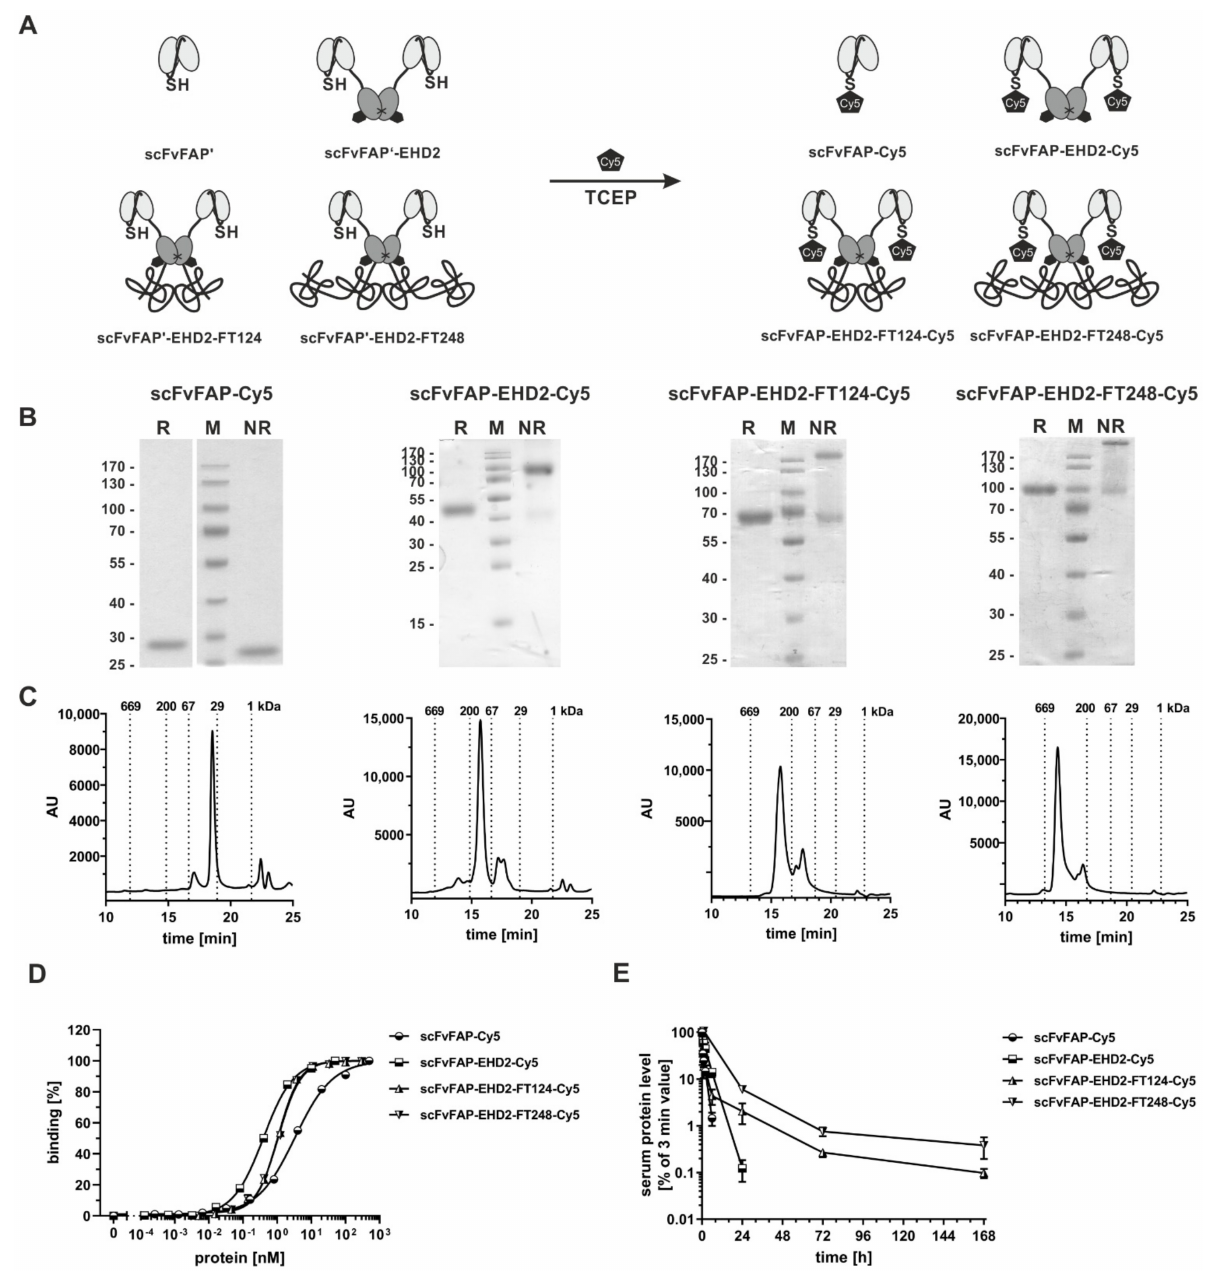
Figure 5. Analysis of scFvFAP-EHD2-based antibody molecules conjugated with Cy5. ( A ) Schematic illustration of Cy5-conjugation of the Cys-modified molecules. By the addition of TCEP and melimide-Cy5, fluorophore-labeled molecules were generated. ( B ) SDS-PAGE analysis of the purified anti-FAP molecules (scFvFAP-Cy5, scFvFAP-EHD2-Cy5, scFvFAP-EHD2-FT124-Cy5, scFvFAP-EHD2-FT248-Cy5) under reducing (R) and non-reducing (NR) conditions in a 12% ( m / v ) acrylamide gel (3 µ g was loaded per lane; M: marker). ( C ) Size-exclusion chromatography of puri- fied scFvFAP-EHD2 molecules. ( D ) Binding of different bivalent scFvFAP-EHD2-Cy5 molecules to HT1080-FAP cells in flow cytometry. ( E ) Pharmacokinetic analysis of different scFvFAP-EHD2-Cy5 molecules, which were applied intravenously into immunocompetent CD1 mice. Protein amount of blood samples was determined via ELISA experiments. In case of the terminal half-life, we calcu- lated strong increased differences between the unmodified molecules scFvFAP and scFvFAP-EHD2 compared to the modified scFvFAP-EHD2-FT molecules (****) and also for the drug exposure for the scFvFAP-EHD2-FT248 compared to all other molecules (****). Mean ± SD, n =